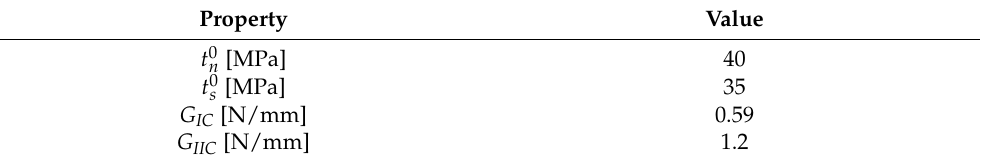
Table 3. CFRP cohesive properties